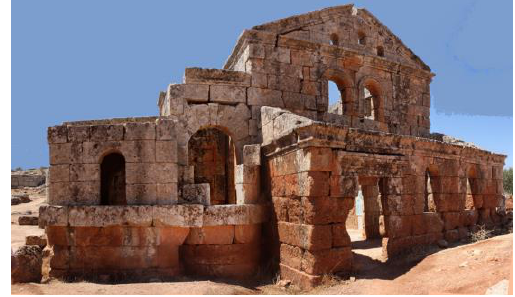
Figure 16 – Serjilla the dead city